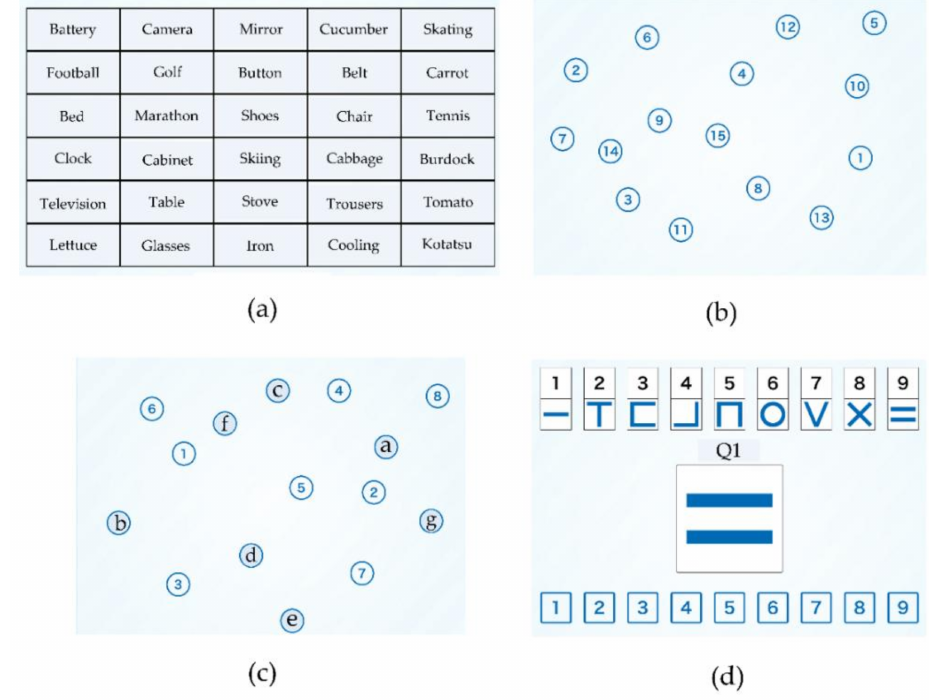
Figure 3. Example of NCGG-FAT. ( a ) Subject 1: Tablet Version of Word list Memory. ( b ) Subject 2, Tablet Version of Trail Making Test Version A. ( c ) Subject 3, Tablet Version of Trail Making Test Version B. ( d ) Subject 4: Symbol Digit Substitution